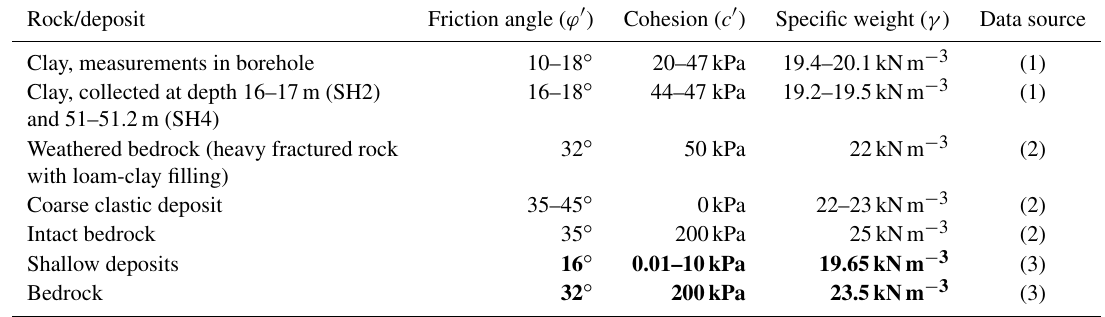
Table 1. Geo-mechanical properties of the deposits. The final material properties used for the modeling are presented in bold. Rock/deposit